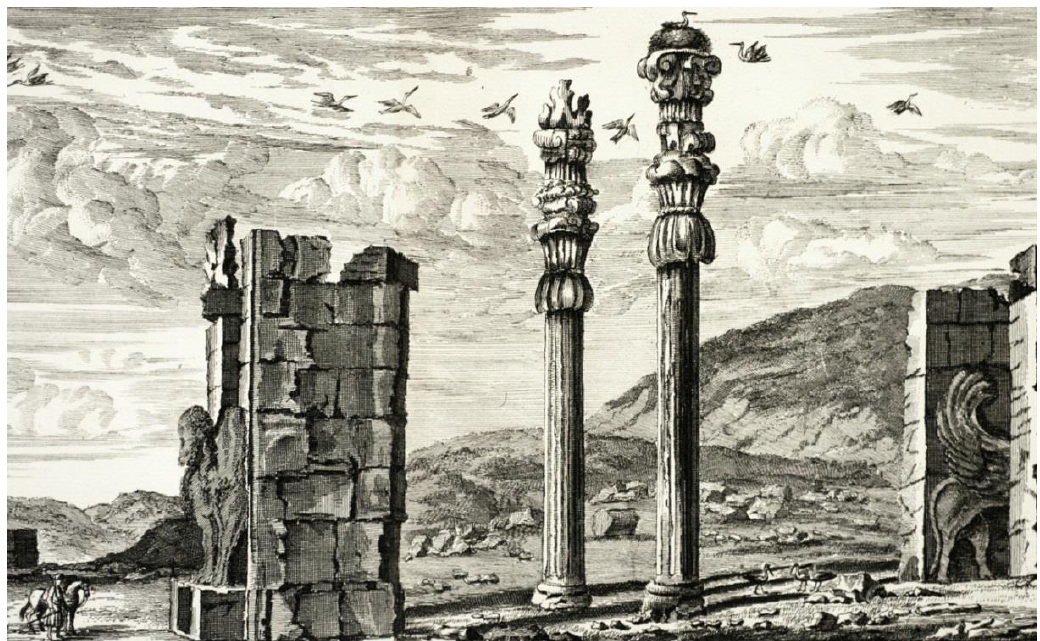
Figure 6. The Gate of All Nations, Published in Persepolis Illustrata , PL. X (The original illustration is partly reproduced here). Source: Collection of Azita Bina and Elmar W. Seibel.